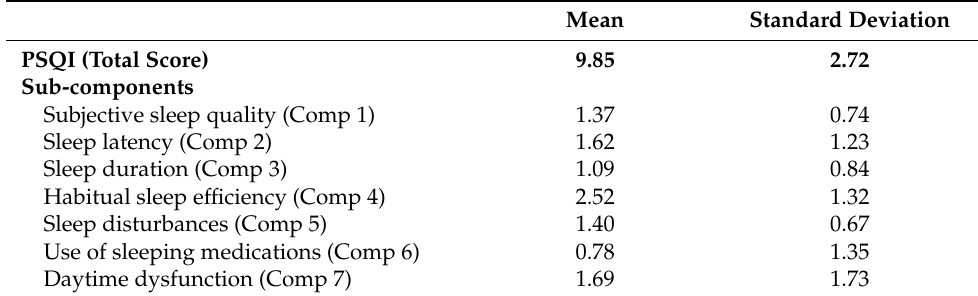
Table 2. Descriptive Statistics of Pittsburgh Sleep Quality Index Scores ( n = 215).